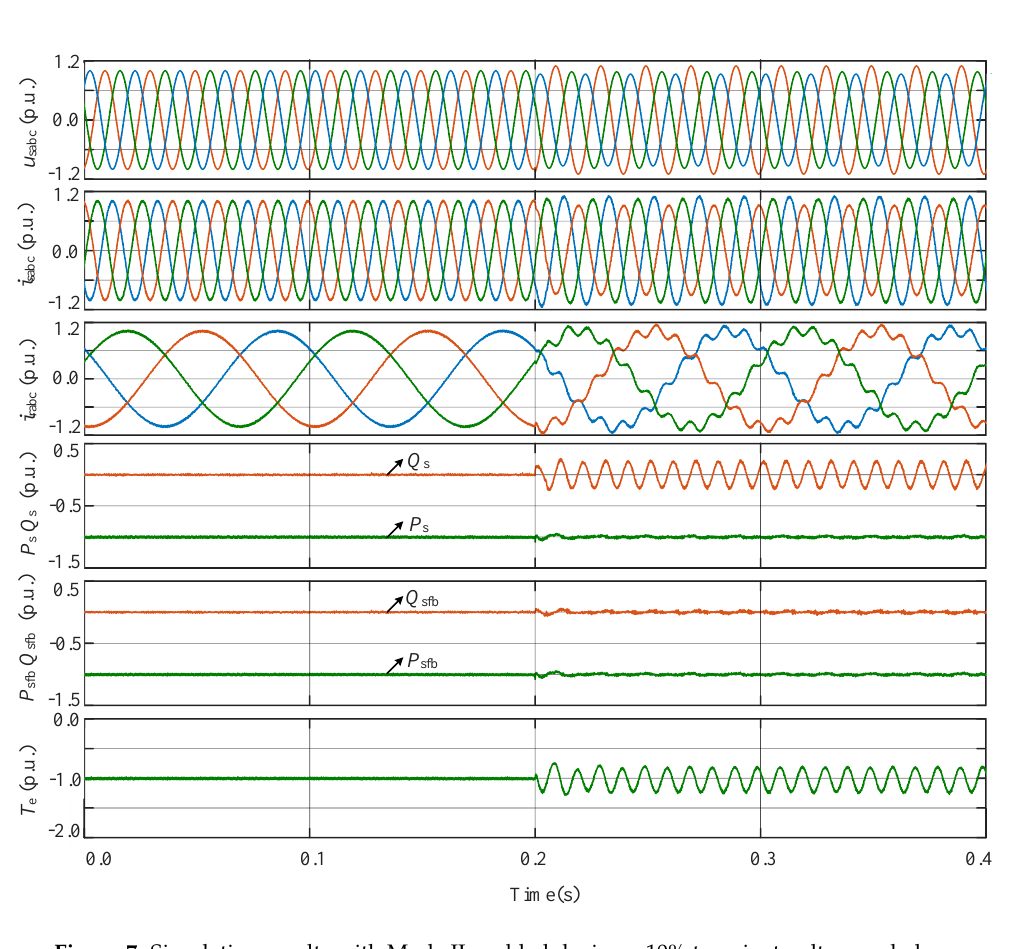
Figure 7. Simulation results with Mode II enabled during a 10% transient voltage unbalance.